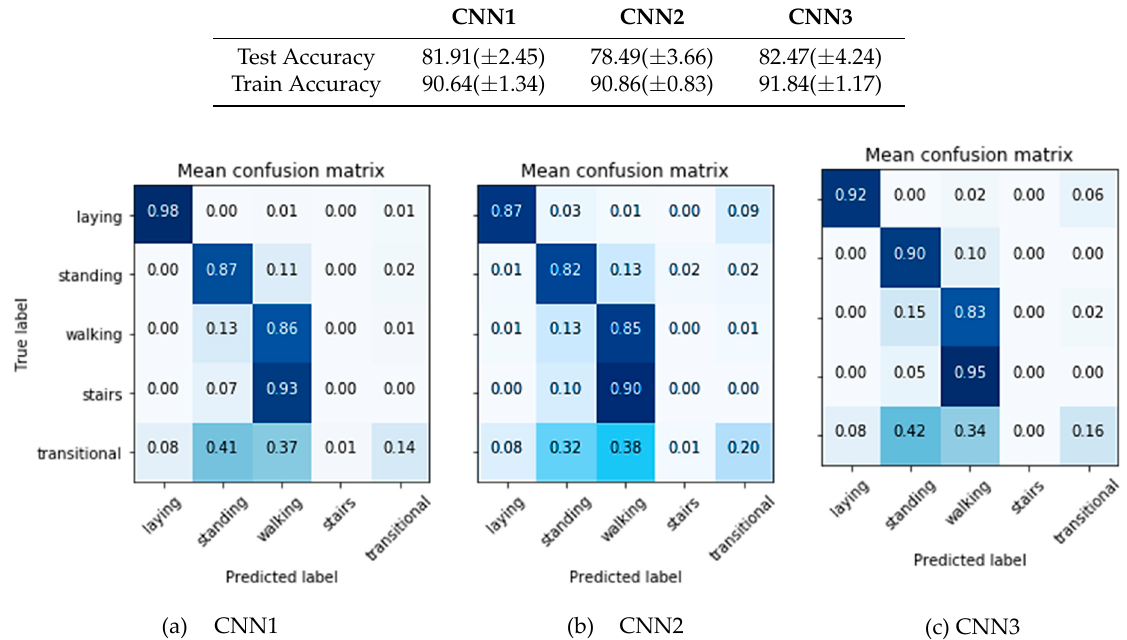
Figure 5. Average confusion matrices of classification of the test set using the 3 investigated deep network architectures.